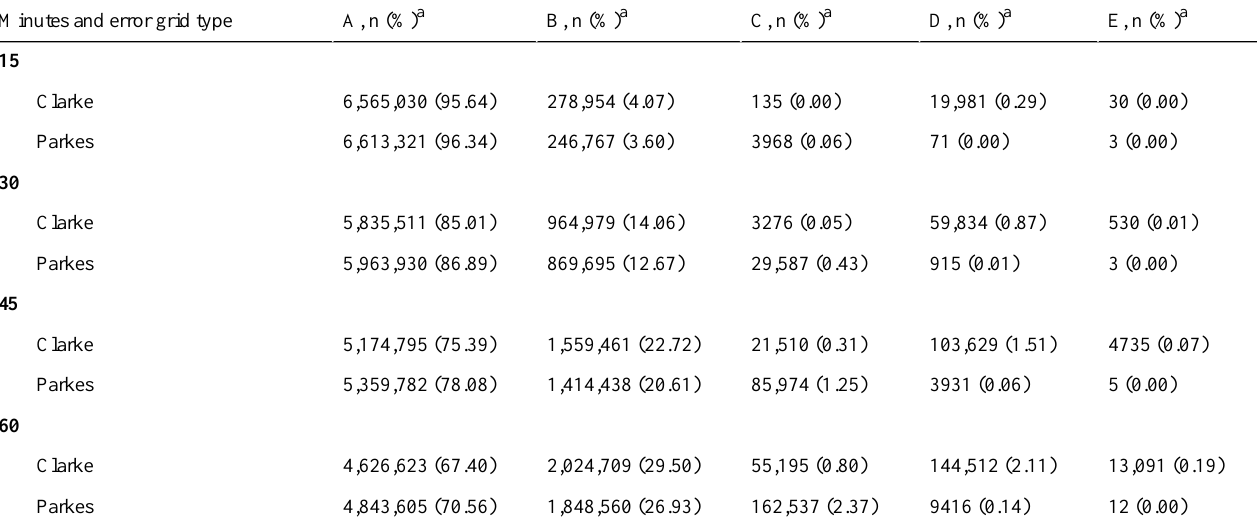
Table 1. Results of error grid analysis of the prediction accuracy of Diabits based on 6,864,130 actual predictions made for 500 most active app users in 2019.